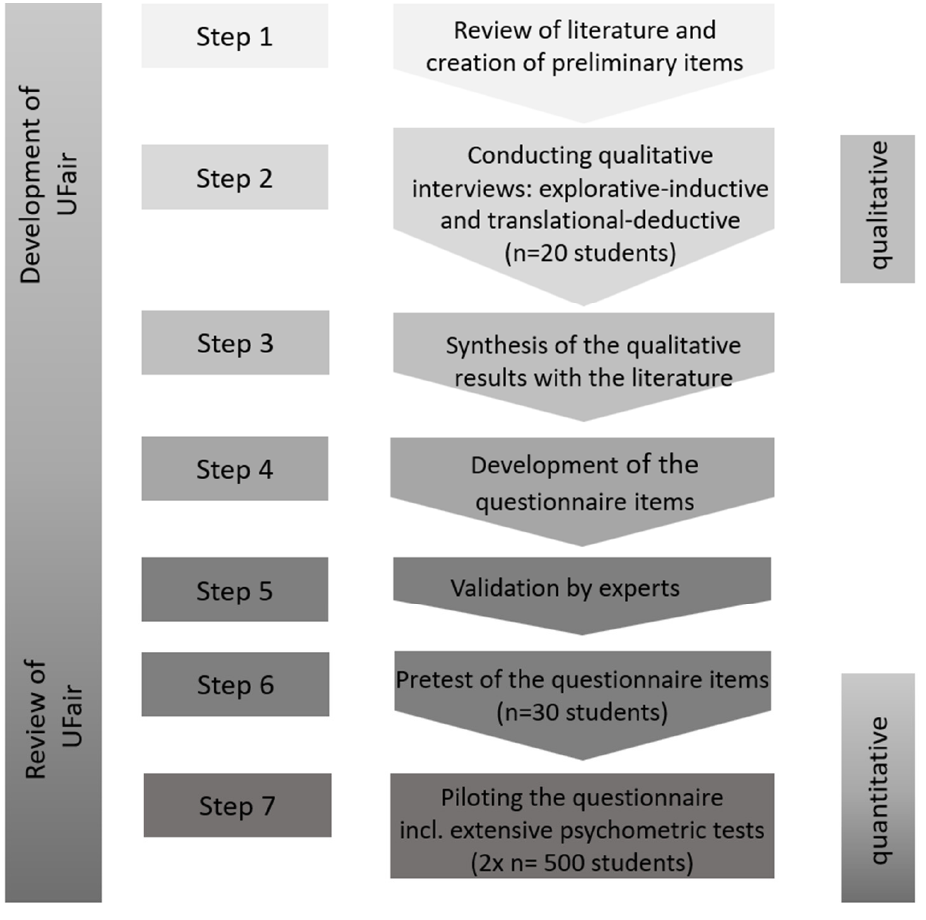
Figure 2. Steps of the questionnaire development UFair following Artino et al. (2014) [50] .